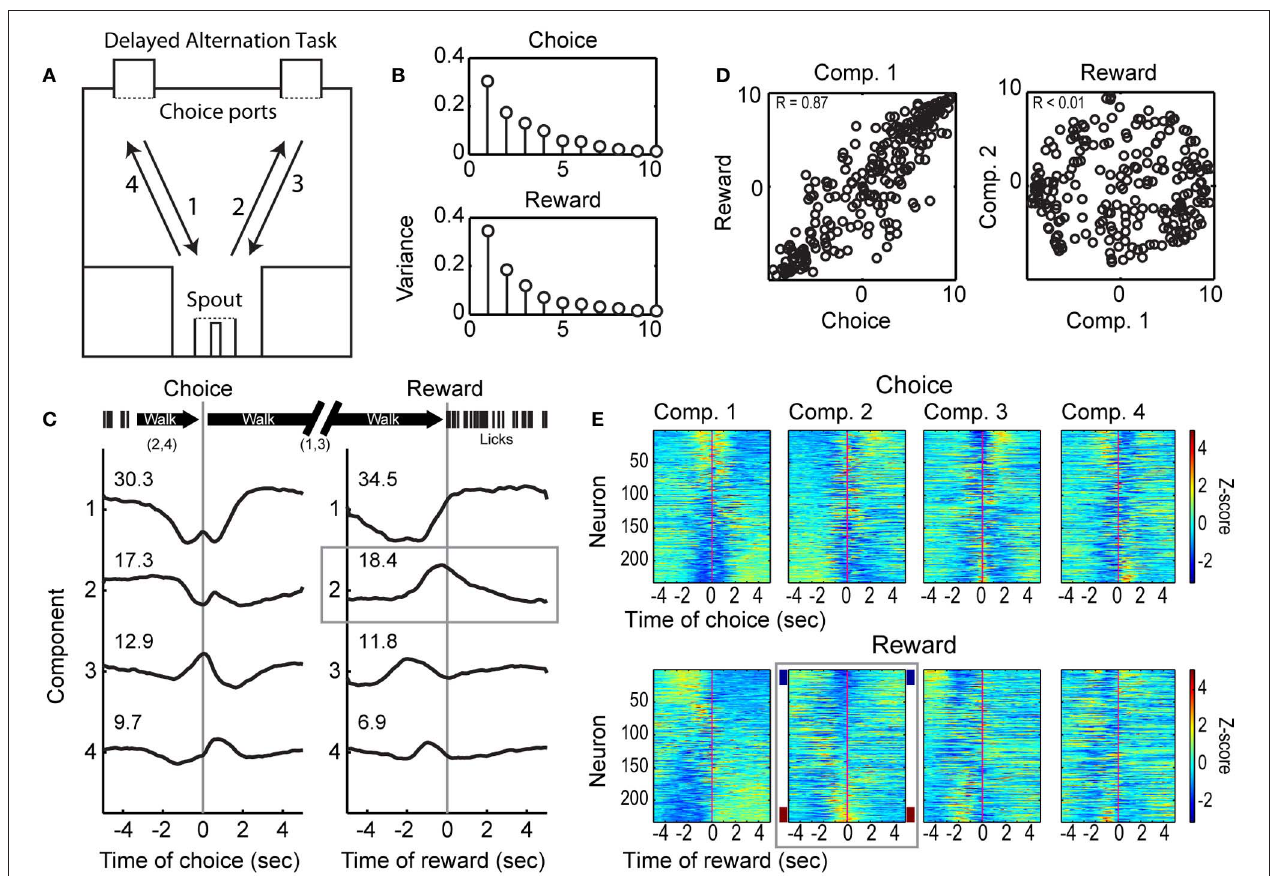
FIGURE 1 | Choice- and reward-related modulations of spike activity in the delayed alternation task. (A) Design of the operant-delayed alternation task. Rats responded at two “choice ports” located on one side (top) of an operant arena. They received water from a spout, located on the opposite side of the arena (bottom), if they responded in an alternating manner at the choice ports (e.g., following arrows 1–4). (B) Temporal patterns of population activity from mPFC were quantified using PCA across the 249 neurons recorded across 5 rats (Narayanan and Laubach, 2009). The variances associated with the 10 leading Components based on activity around the choice and reward events are shown. (C) Population activity associated with the four leading Components for the choice and reward events. The first Components for each event were dominated by fluctuations between periods of locomotion. The second Component for the reward event was associated